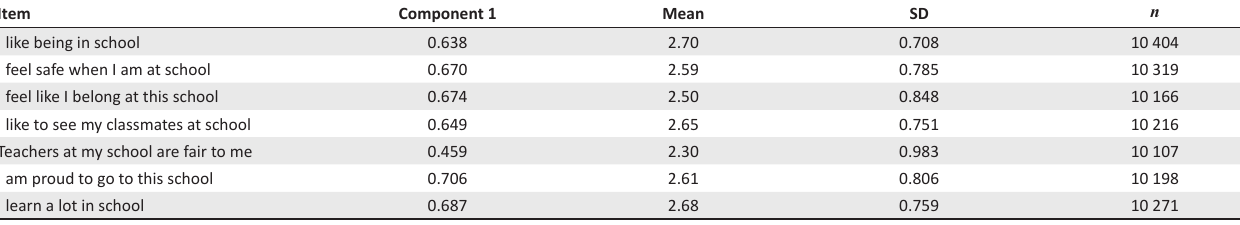
TABLE 3-A1: Factors used in the calculation of the index sense of school belonging. Item